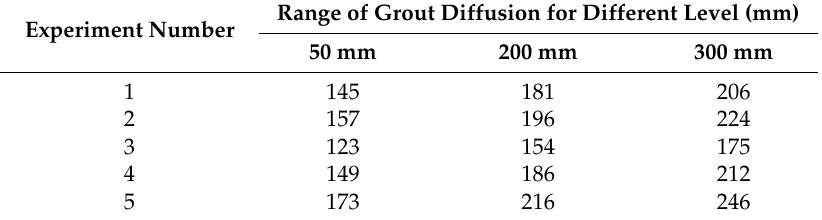
Figure 8. Grout diffusion range diagram for different levels of experiment 1: ( a ) 50 mm; ( b ) 200 mm; and ( c ) 300 mm. Table 4. Range of grout diffusion for different levels during different